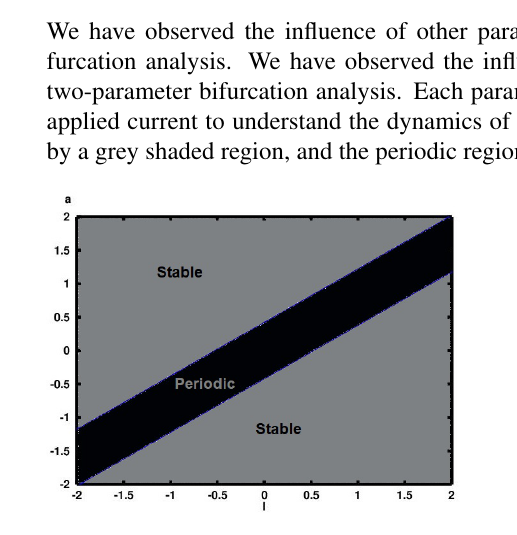
Figure 43. Two-parameter bifurcation of pa- rameter a concerning the external applied cur- rent with parameters a = 0.8 , b = 0.7 & c = 3 . Sta- ble state is shown by grey shaded region) and unstable by black shaded region